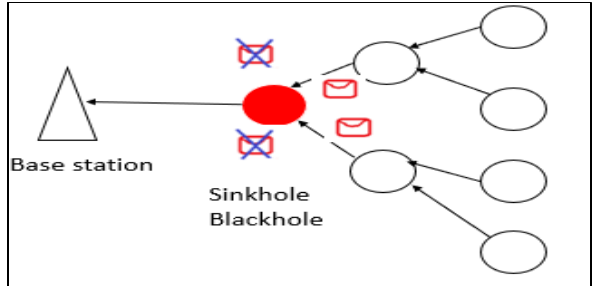
Figure 3. An illustration of the Blackhole attack 2.2.3. Greyhole Attack: This attack also named “selective